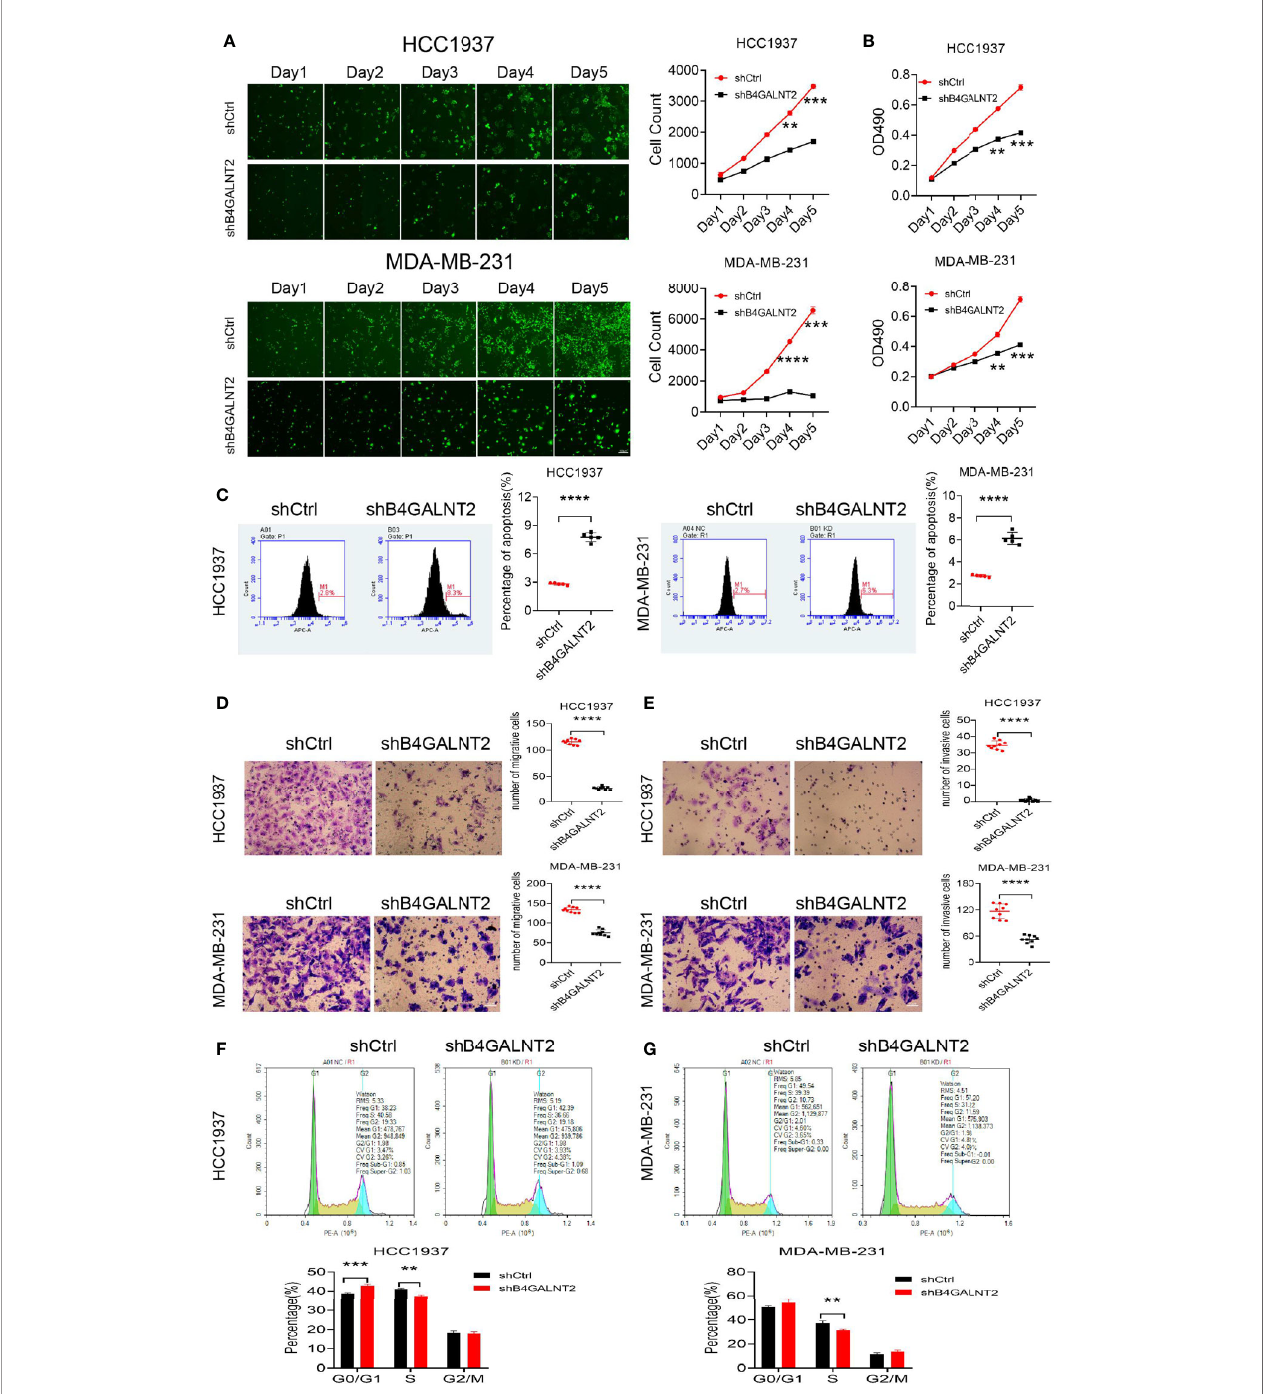
FIGURE 3 | The effects of B4GALNT2 gene on the cell proliferation, invasion, migration and cycle of breast cancer cell lines were investigated by in-vitro cell experiments. (A) Using Celigo instrument, through counting for 5 consecutive days, it was found that the proliferation ability of the cells of the shB4GALNT2 group were signi fi cantly lower than that of the shCtrl group; (B) MTT assay was used for detection of the cell viability. After 5 consecutive days of detection, it was observed that the cell viability of shB4GALNT2 group was signi fi cantly lower than that of shCtrl group. (C) Flow cytometry was used for determining the early apoptosis rate of cells transfected with lentivirus, where it was found that the apoptosis rate of cells in shB4GALNT2 group was higher. (D, E) Transwell assay was used for measuring the migration and invasion abilities of cells after knockdown of B4GALNT2 gene, where it was found that the migration and invasion ability of cells in shB4GALNT2 group were signi fi cantly reduced. (F, G) Flow cytometry was used for detecting the cell cycle, where it was found that the B4GALNT2 gene knockdown resulted in signi fi cant G1 phase arrest. **p < 0.01, ***p < 0.001, ****p <